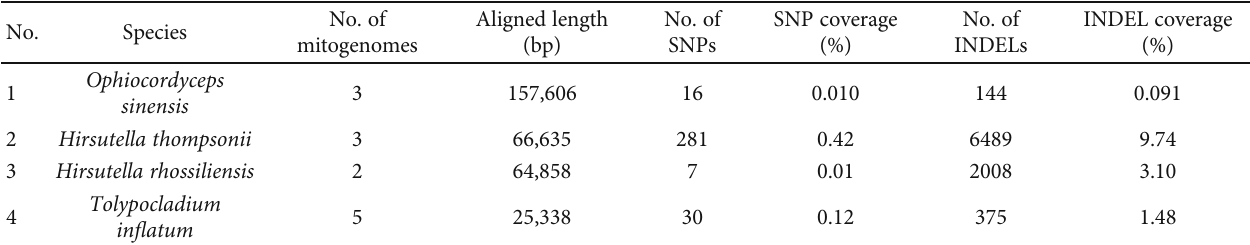
Table 5: Number of intraspeci fi c variations identi fi ed from four fungal species belonging to Ophiocordycipitaceae. No.